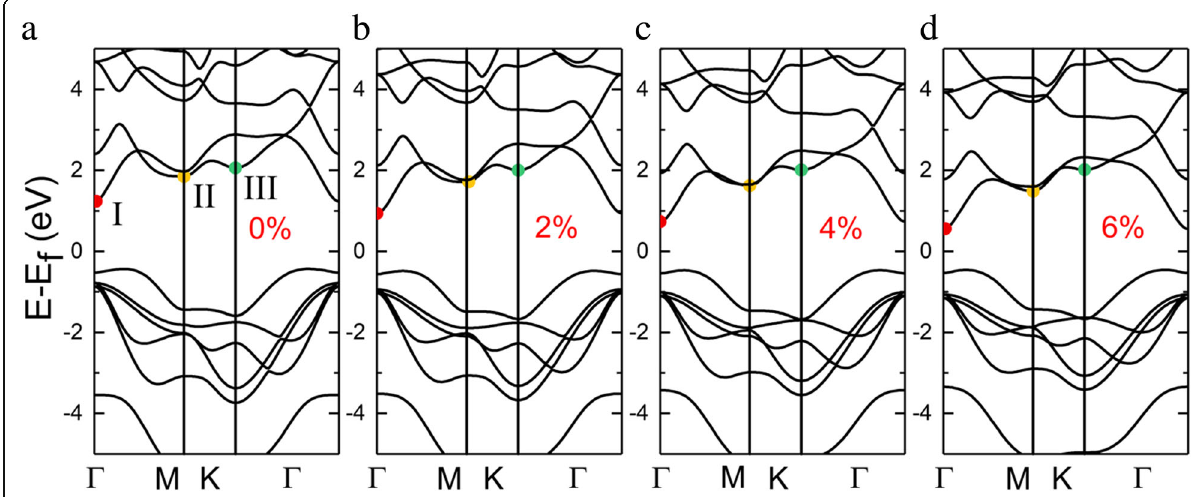
Fig. 2 Band structure of InSe monolayer under different strain